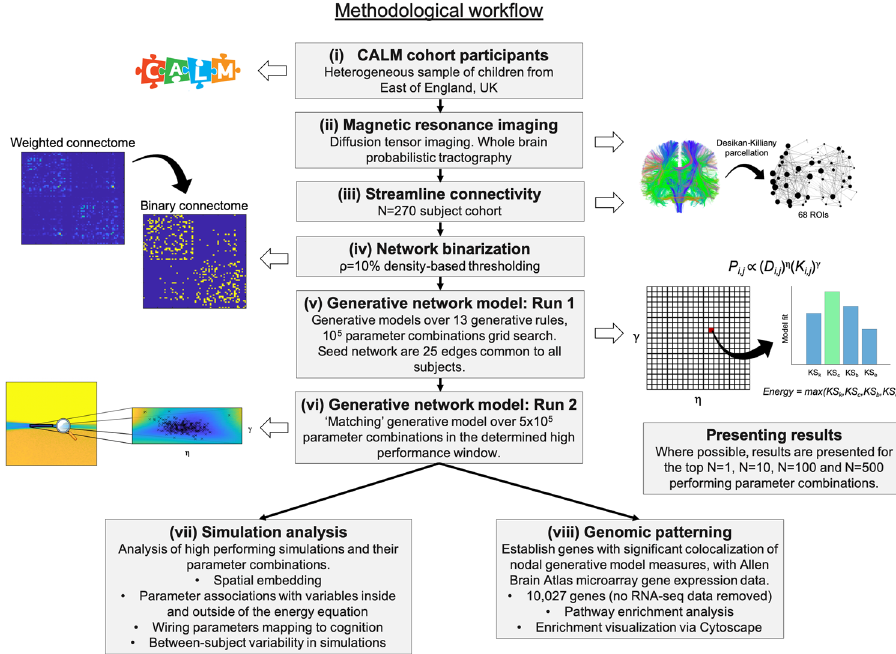
Fig. 8 Schematic of the methodological work fl ow. The basic work fl ow involved (i) Recruitment of the CALM cohort, a heterogeneous referred sample from the East of England (UK) with wide inclusion criteria; (ii) MRI diffusion tensor imaging; (iii) Estimation of structural connectivity within the Desikan – Killiany parcellation; (iv) Binarization of the connectome; (v) Initial run of the GNM for all 13 generative rules as outlined in Supplementary Table 1; (vi) More speci fi c run of the homophily “ matching ” GNM in the narrow parameter window; (vii) Further analysis of simulations in terms of spatial embedding, parameter associations and variability; (viii) Combination of Allen Human Brain Atlas data and the generative model fi